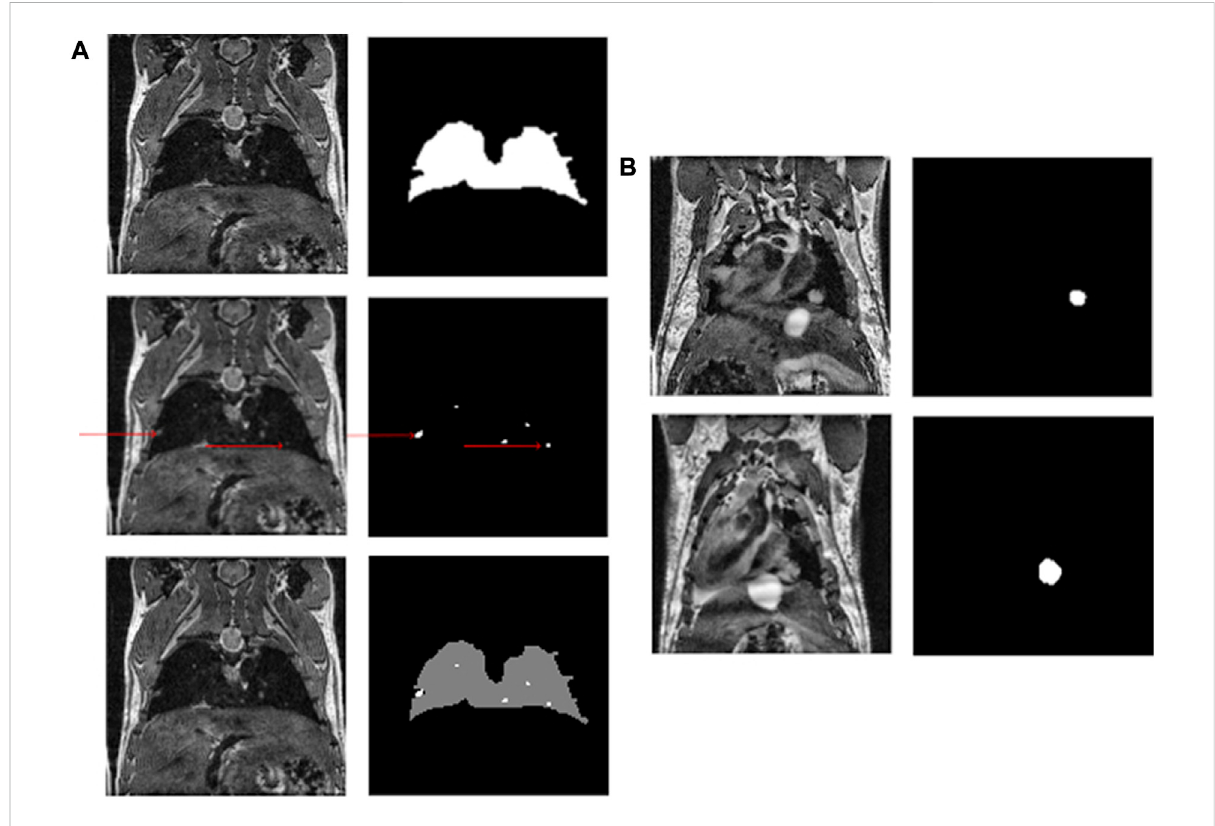
FIGURE 2 (A) An example of a mouse slice, the lung and metastasis masks (red arrows indicate metastases) and the multiclass resulting mask. (B) Shows the growth of a metastasis over